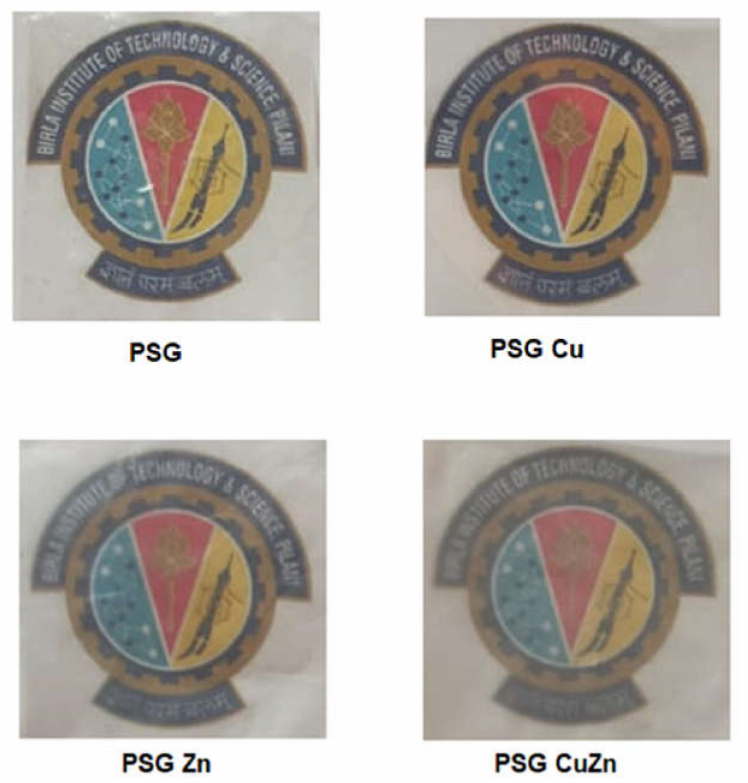
Figure 6. Images displaying the transparency of polymer films to visible light. To study the rate of their degradation, the polymer films were incubated in autoclaved and non-autoclaved garden soil. Figure 7a demonstrates the rate of degradation of the polymer films incubated in sterile and non-sterile soil over 56 days, while Figure 7b shows the images of the polymer films upon degradation. The biodegradation rate of the polymer films were analyzed by studying the weight loss of the polymer films. Maximum degrada- tion (50%) was observed for the PSG film placed in non-sterile soil, while the nanoparticle incorporated polymers exhibited a comparatively lowered degradation rate at 38–40%. This was due to the antimicrobial activity of the CuO and ZnO nanoparticles, which prevented or lowered the microbial action for degradation of the polymers, thereby increasing their stability [41]. A significant difference in the degradation rate of polymer films was observed in non-sterile soil and sterile soil, indicating the role of microorganisms in degradation.